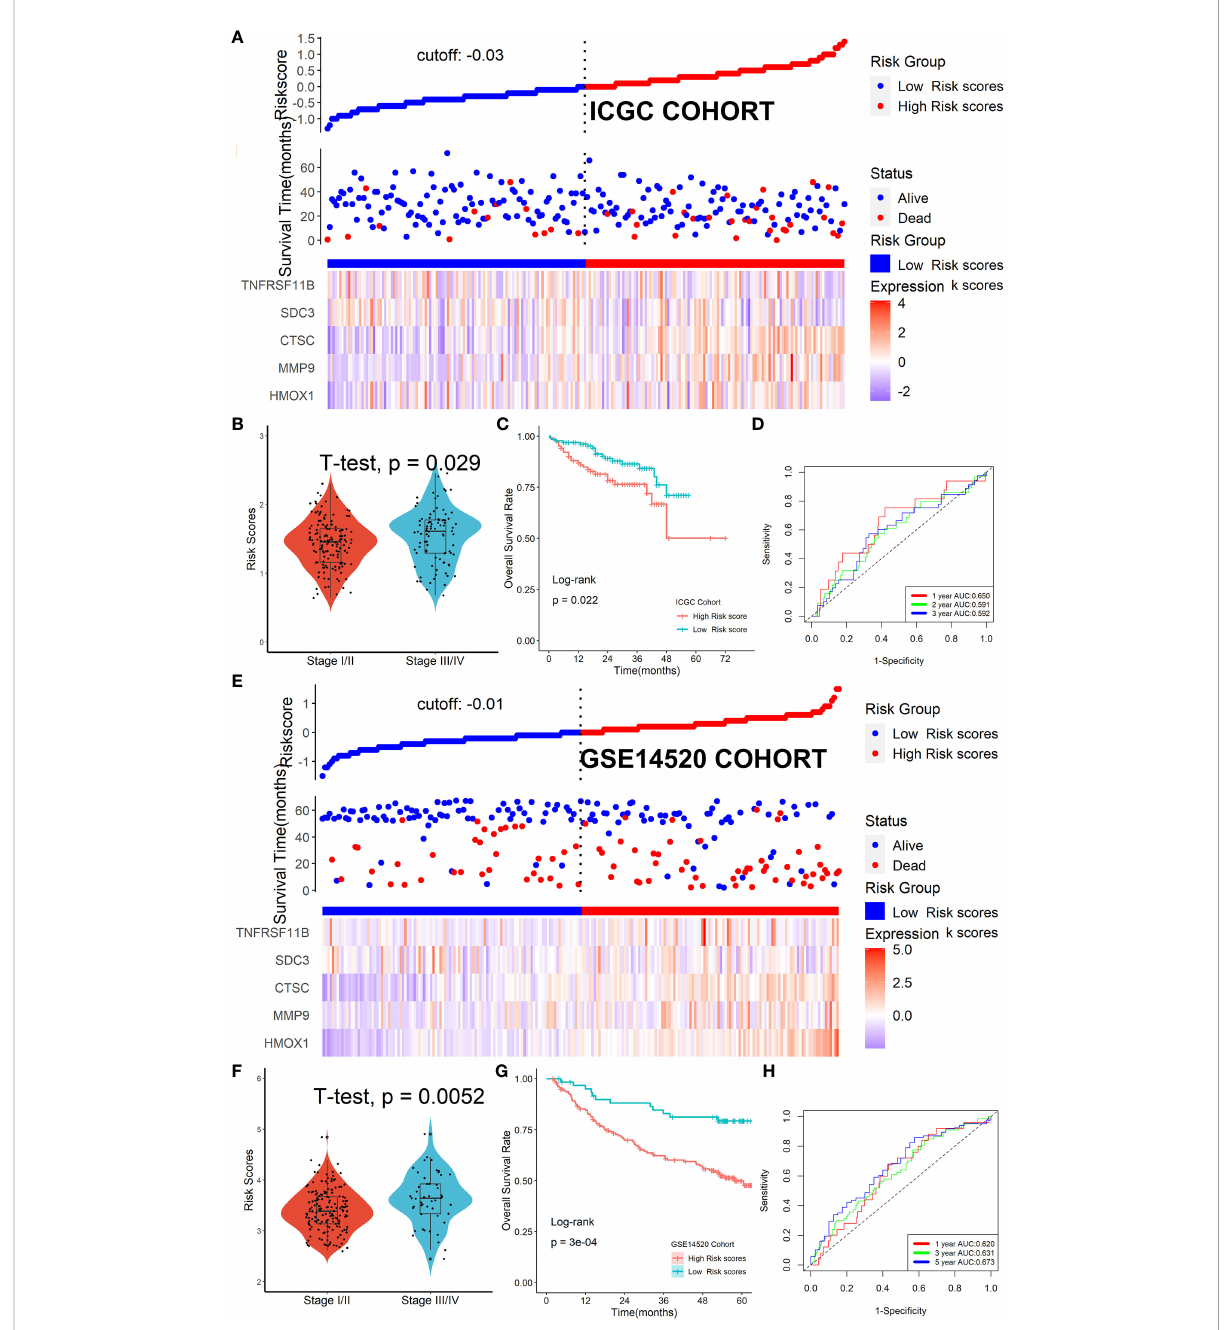
FIGURE 6 Veri fi cation of the Tregs-related signature in external cohorts. Patients were split into high- or low-risk categories in ICGC (A) and GSE14520 (E) cohorts. Patients in the later TNM stage had greater risk ratings than patients in the early stage, no matter whether we looked at the ICGC cohort (B) or the GSE14520 cohort (F) . Patients with lower risk scores were strongly associated with higher OS rates both in the ICGC cohort (C) and the GSE14520 cohort (G) . This Tregs-related signature had a good prognostic performance no matter in the ICGC cohort (D) or the GSE14520 cohort (H)